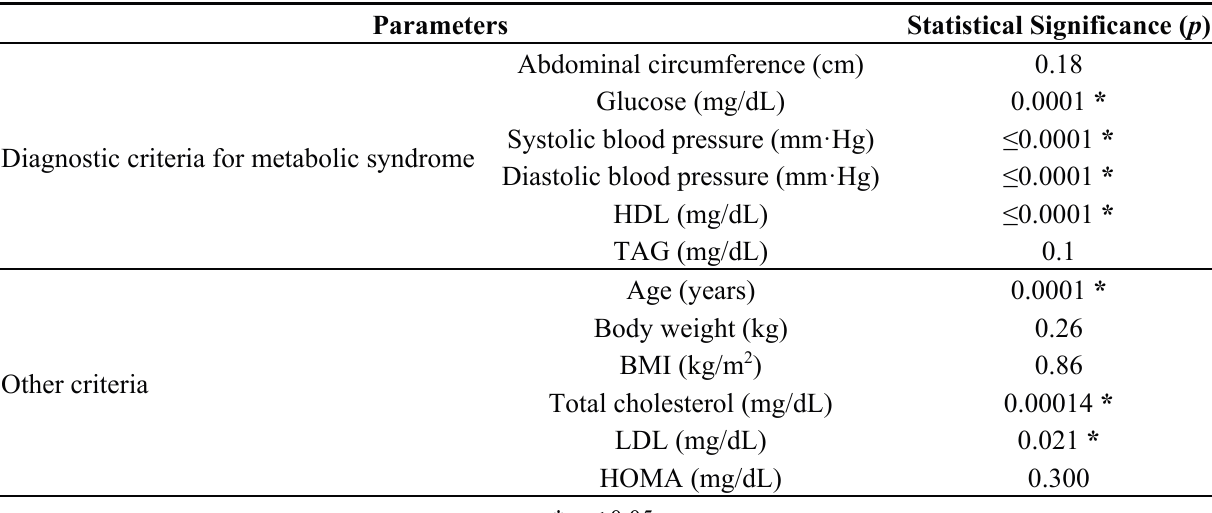
Table 4. The statistical significance between the parameters in patients with and without benign prostatic